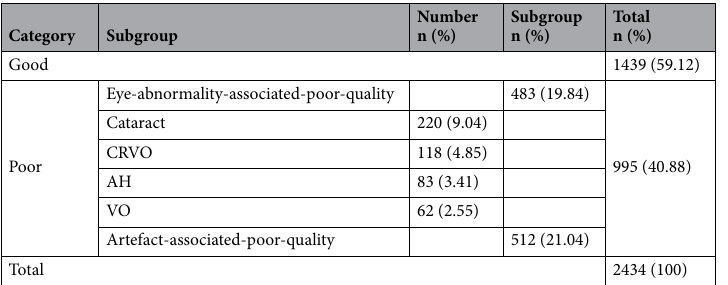
Table 2. Summary of images in the primary dataset used for training, testing, and 10-fold cross validation. CRVO central retinal vein occlusion, AH Asteroid hyalosis, VO Vitreous